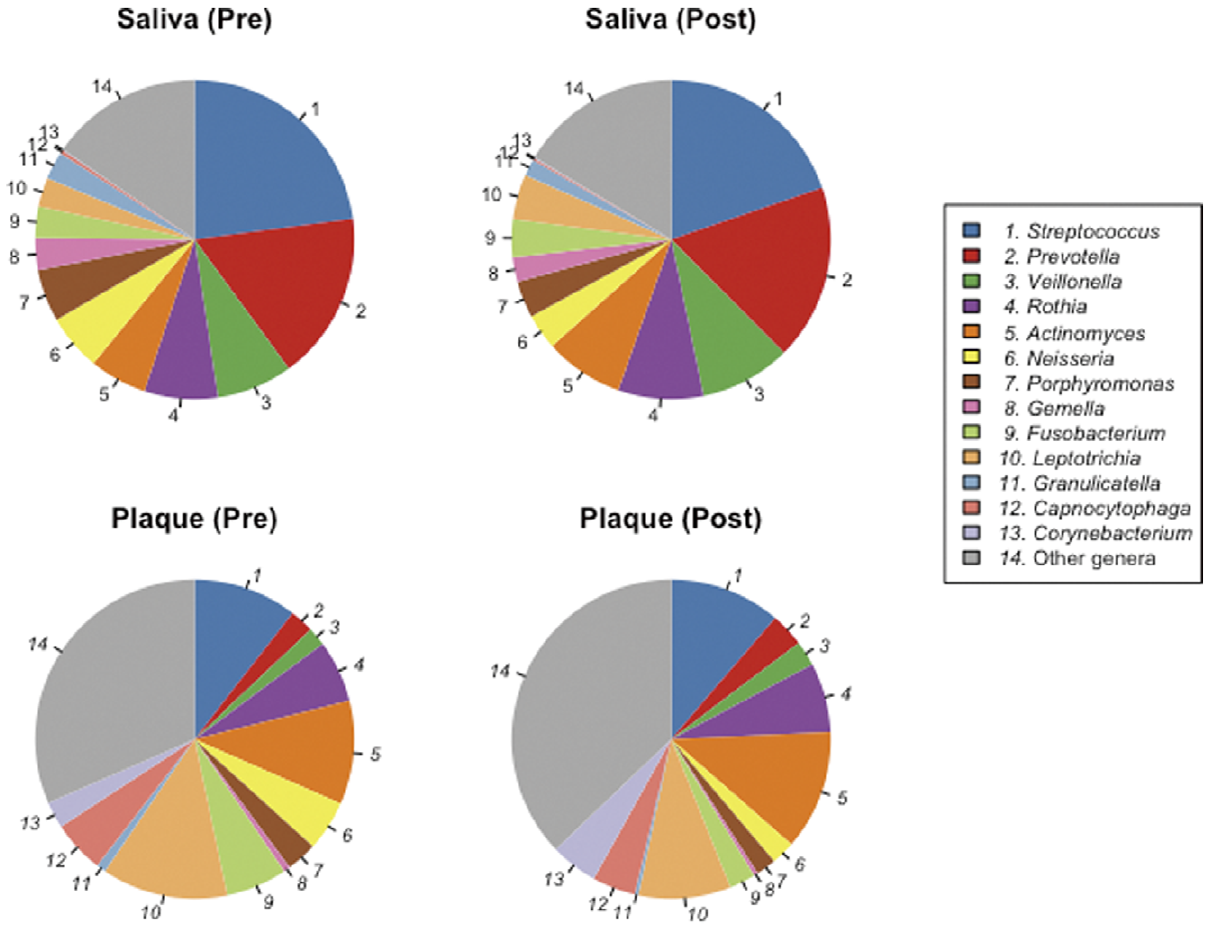
Figure 4. Mean genus abundances in the supragingival plaque microbiota and salivary bacterial population before and after periodontal therapy. Only 13 genera commonly detected in supragingival plaque or saliva samples are shown.